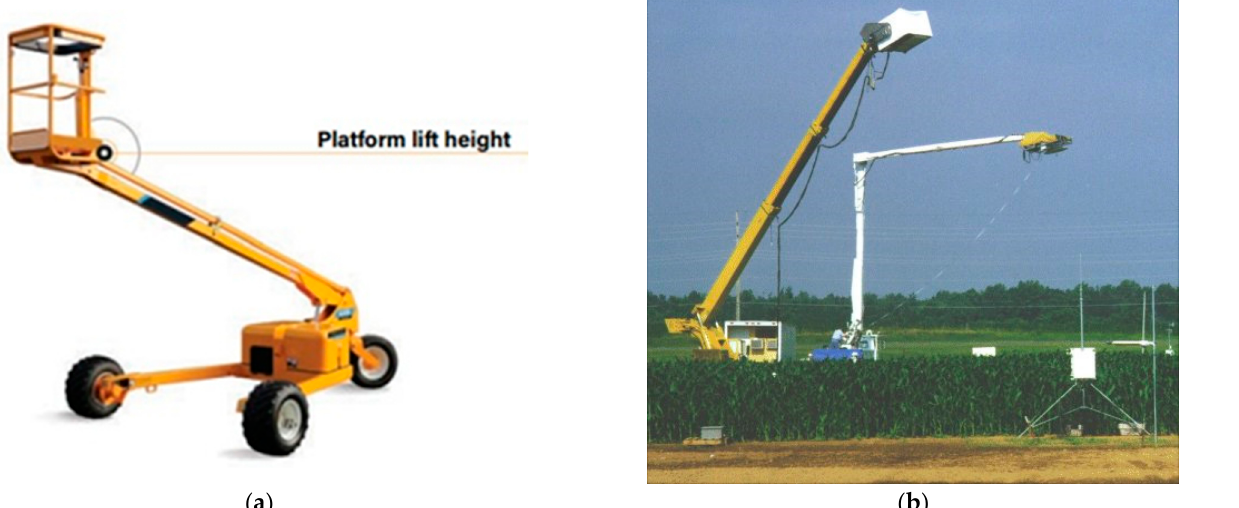
Figure 5. ( a , b ) Ground-borne platforms (source: https://www.brainkart.com/article/Remote-sensing-platform_41126/, accessed on 14 October 2022 and https://weather.msfc.nasa.gov/landprocess/lp_gbe.html, accessed on 4 November 2022.